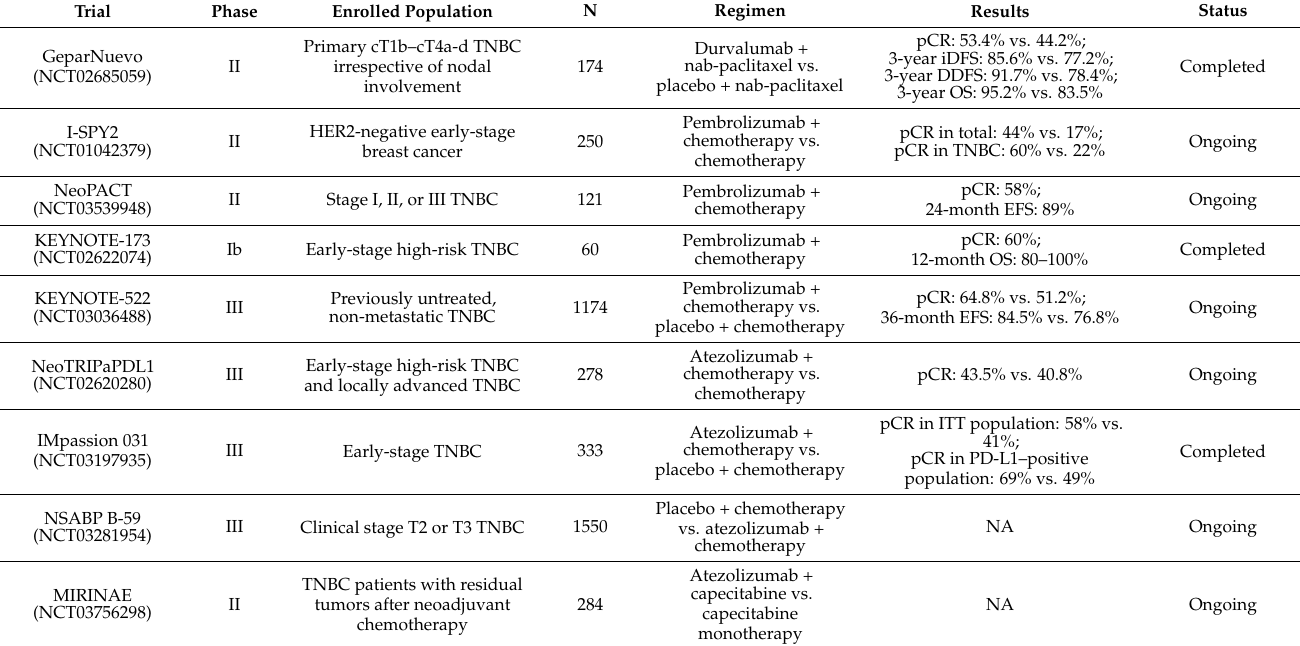
Table 1. PD-1/PD-L1 inhibitors plus neoadjuvant chemotherapy trials in early-stage